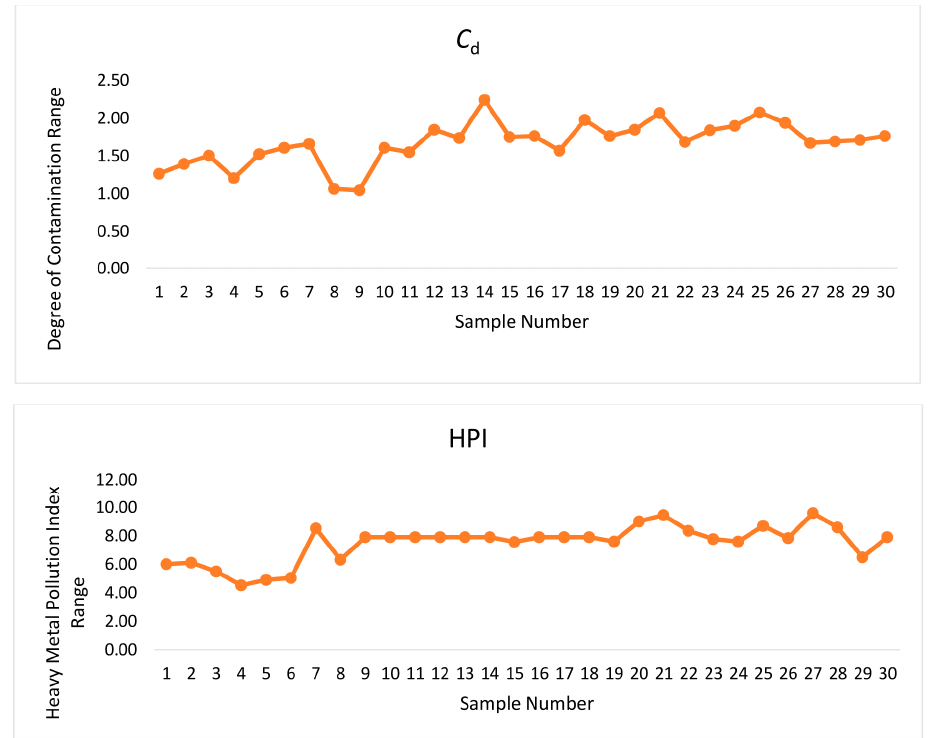
Figure 4. Distribution of degree of contamination (C d ) and heavy metal pollution index (HPI) of Yanbu seawater samples.